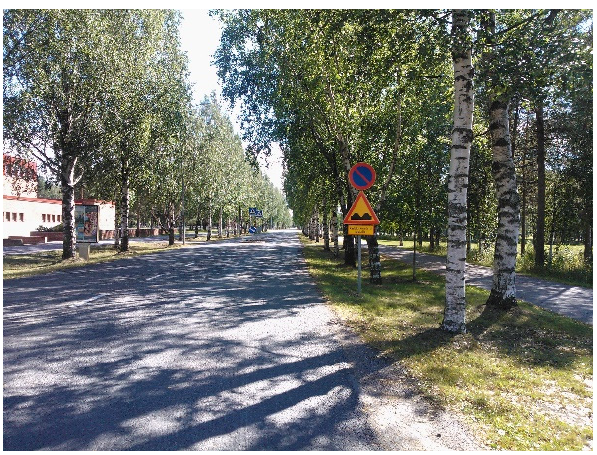
Figure 14. Conditions in summer (location 1).